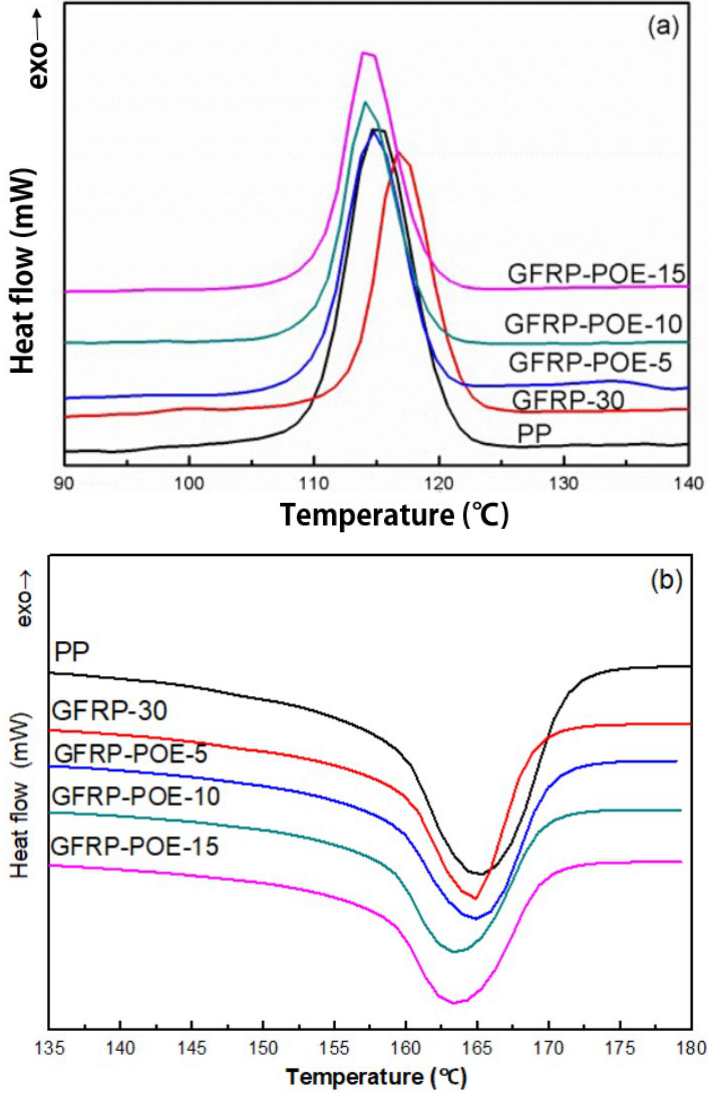
Figure 5. Effects of POE-g-MAH on the crystal behavior and melting behavior of GFRP: ( a ) DSC curves of crystallization behavior; ( b ) DSC curves of melting behavior.